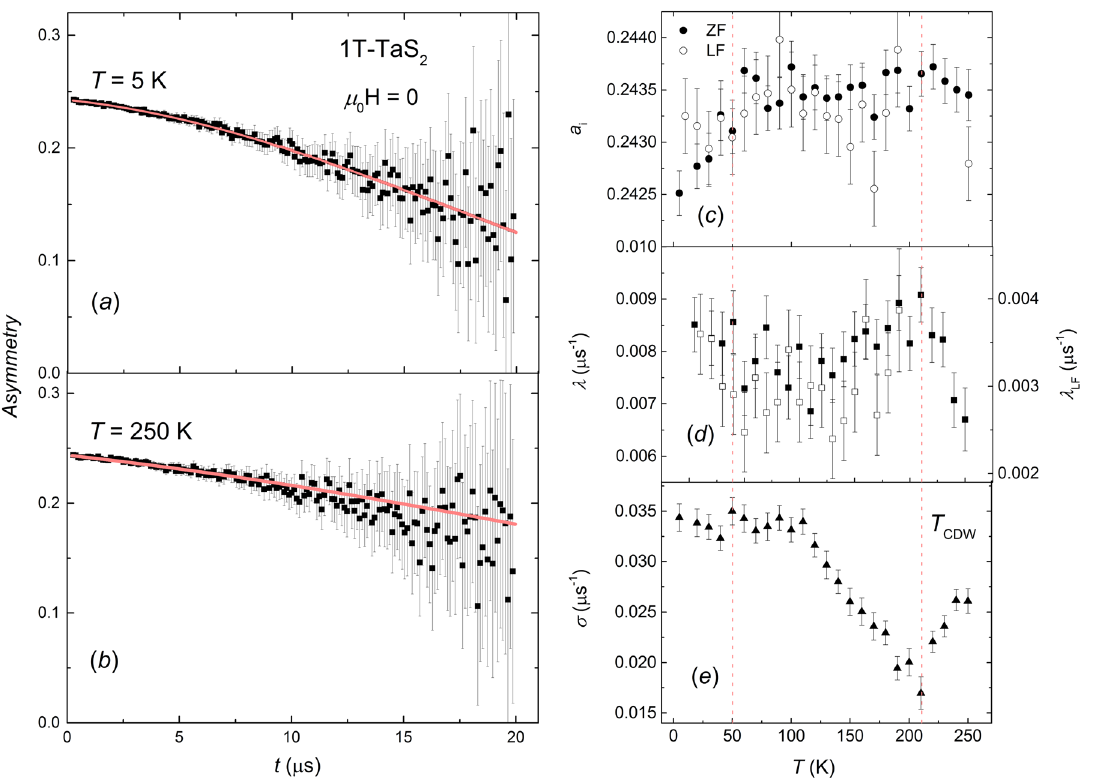
Fig. 4 The µ SR data of 1T-TaS 2 . The ZF µ SR asymmetry spectra of 1T-TaS 2 are measured at a 5 K, and b 250 K; the red line represents the fi t described in the text. Vertical error bars represent 1 σ s.d. counting statistics. Temperature dependence of the initial asymmetry both in the ZF and LF mode c , the relaxation rate d , and the nuclear depolarization rate e , taken from the fi t described in the text. The vertical error bars for a i , λ , and σ are from fi ts. The dashed line at 210 K marks the position of the transition into the CDW state upon cooling. The dashed line at ~50 K marks the temperature where the trend of the three parameters changes which might be associated with the possible onset of the magnetic short-range order at low